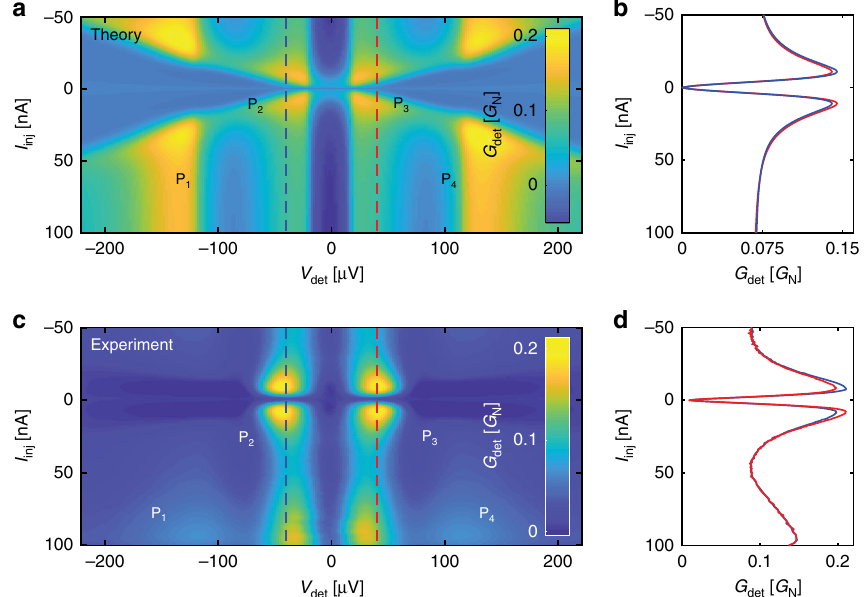
Fig. 4 Spin energy mode. H = 1 T for this fi gure. a , c Theoretical calculations for and measurements of the detector differential conductance as a function of detector voltage and injection current for the detector J det1 . The peaks P 1 – P 4 observed experimentally and reproduced in our calculations are due to spin down (P 2 , P 3 ) and spin up (P 1 , P 4 ) excitations. b , d Vertical slices of a and c at eV det ¼ ± j Δ (cid:2) Δ det (cid:2) E Z j (red for + and blue for − ), indicated by the dashed blue and red lines in a and c . A charge imbalance can be seen, i.e. the red and blue traces, which give, respectively, the number of electron-like and hole-like non-equilibrium quasiparticles, are not